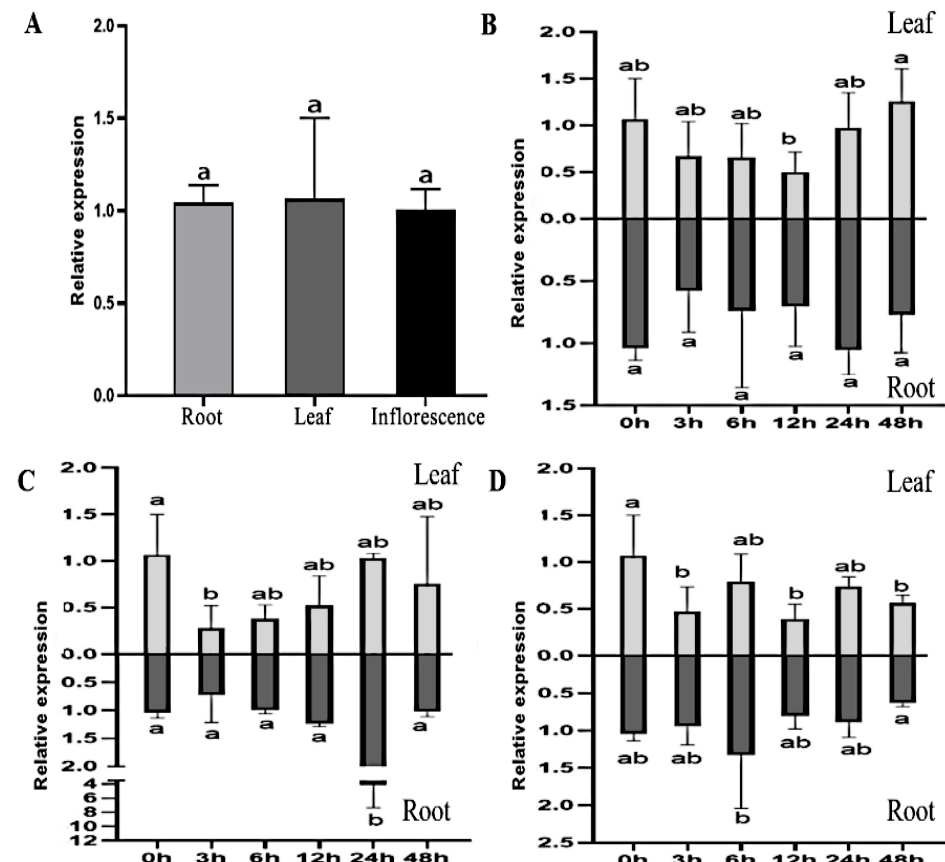
Figure 1. Expression patterns of MsTRX. ( A ) Expression of MsTRX in alfalfa roots, leaves, and inflorescences. ( B ) Expression of MsTRX in alfalfa root and leaf under cold stress. ( C ) Expression pattern of MsTRX in alfalfa root and leaf under drought stress. ( D ) Expression of MsTRX in alfalfa root and leaf under salt stress. Alfalfa seedlings at 6 weeks old were sampled for tissue-specific expression. MsActin was used as the internal reference. The error bars represented the means ± SDs of three independent biological replicates. The different lowercase represented significant differences ( α =